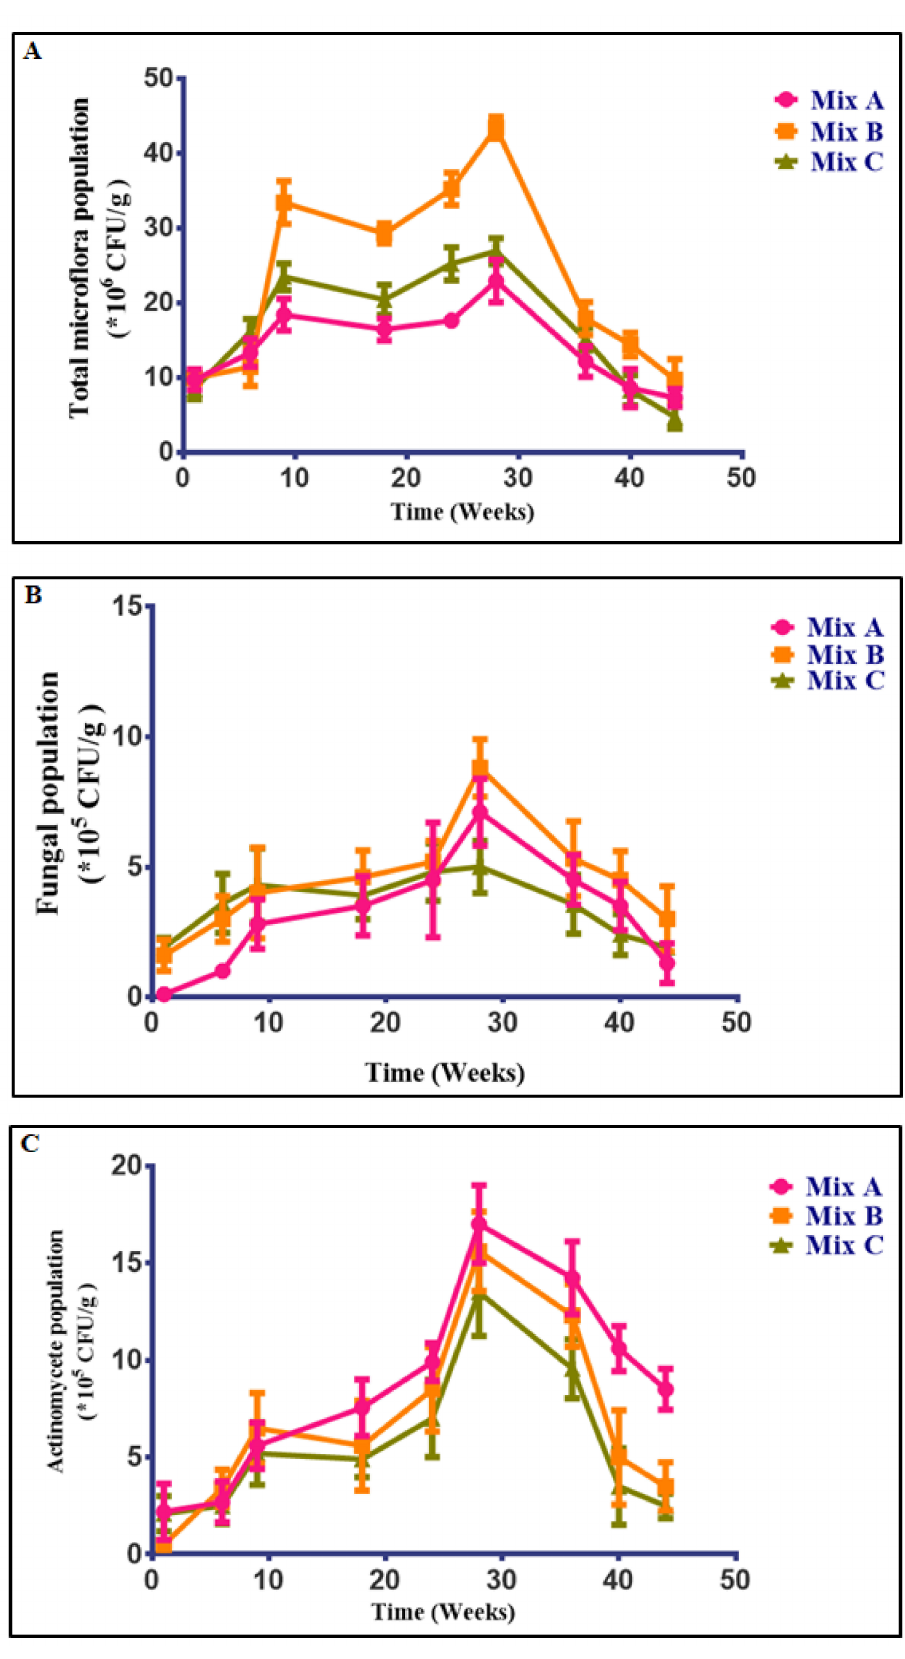
Figure 6. Changes in the total microflora ( A ), fungal ( B ), and actinomycete ( C ) populations during the composting of di ff erent